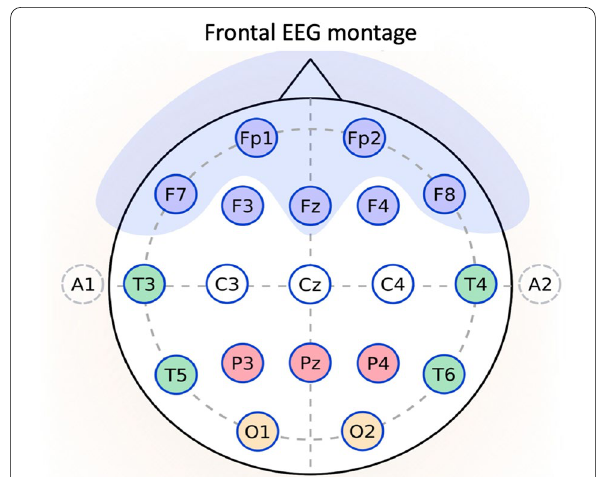
Fig. 1 Montage description. Difference between frontal montage (4 electrodes: Fp1, Fp2, F7 and F8, blue electrodes) and standard montage (21 electrodes/system